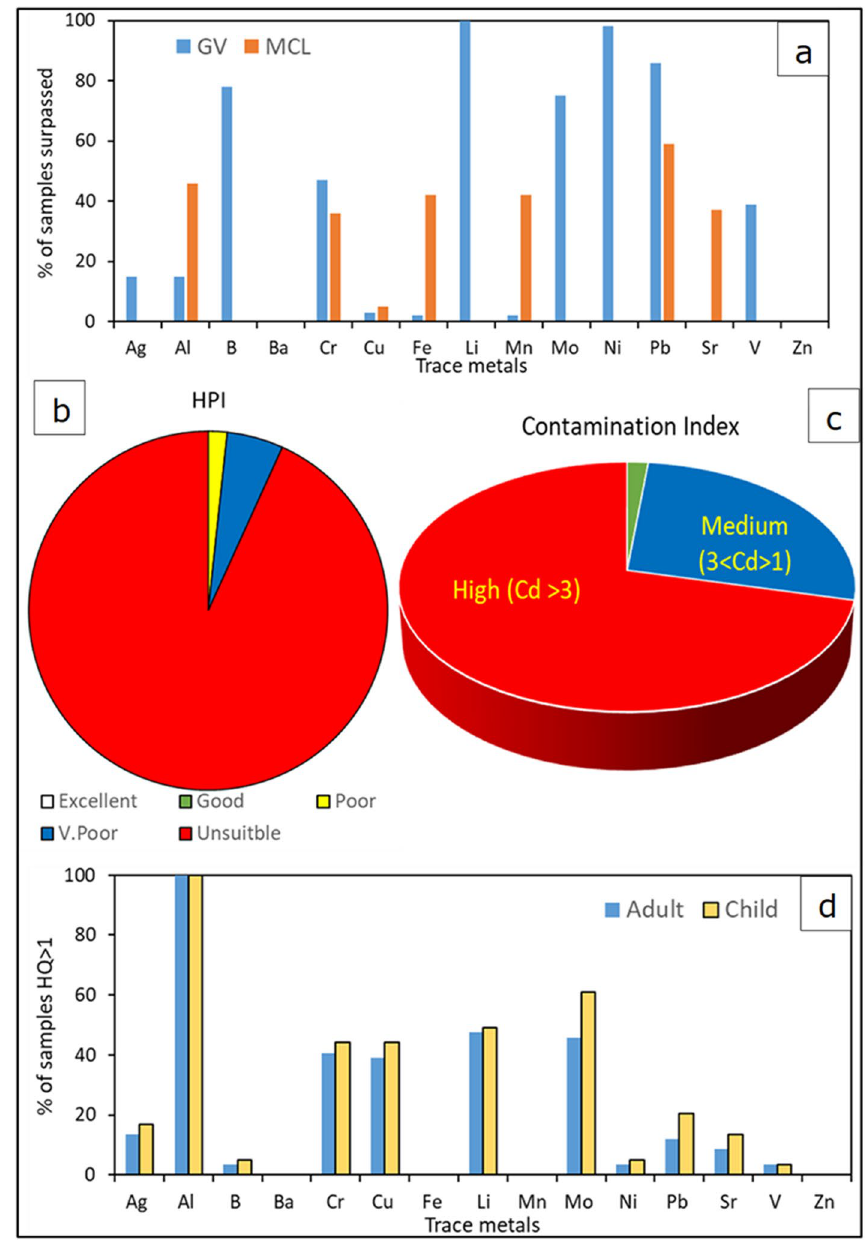
Fig. 2 Water samples surpassed the guideline value (GV) and maximum contamination